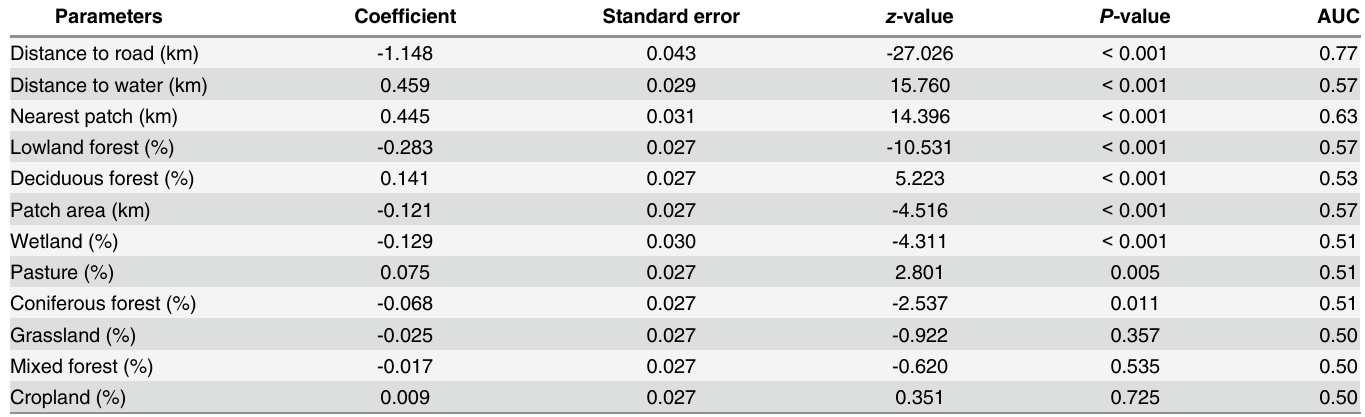
Table 3. Generalized linear mixed-effect models assessing second order resource use of neonatal white-tailed deer ( (cid:1) 14 weeks of age; n = 129) during the post-partum period (14 May – 31Aug), southcentral Upper Peninsula of Michigan, USA, 2009 – 2011. Models used radiolocations (1; n = 2713) and random points (0) as the binomial response variable and individual resources were used as a fixed effect with individual fawn and year as ran- dom effects on the intercept. Model accuracy was estimated using the area under a receiver operating characteristic curve (AUC).